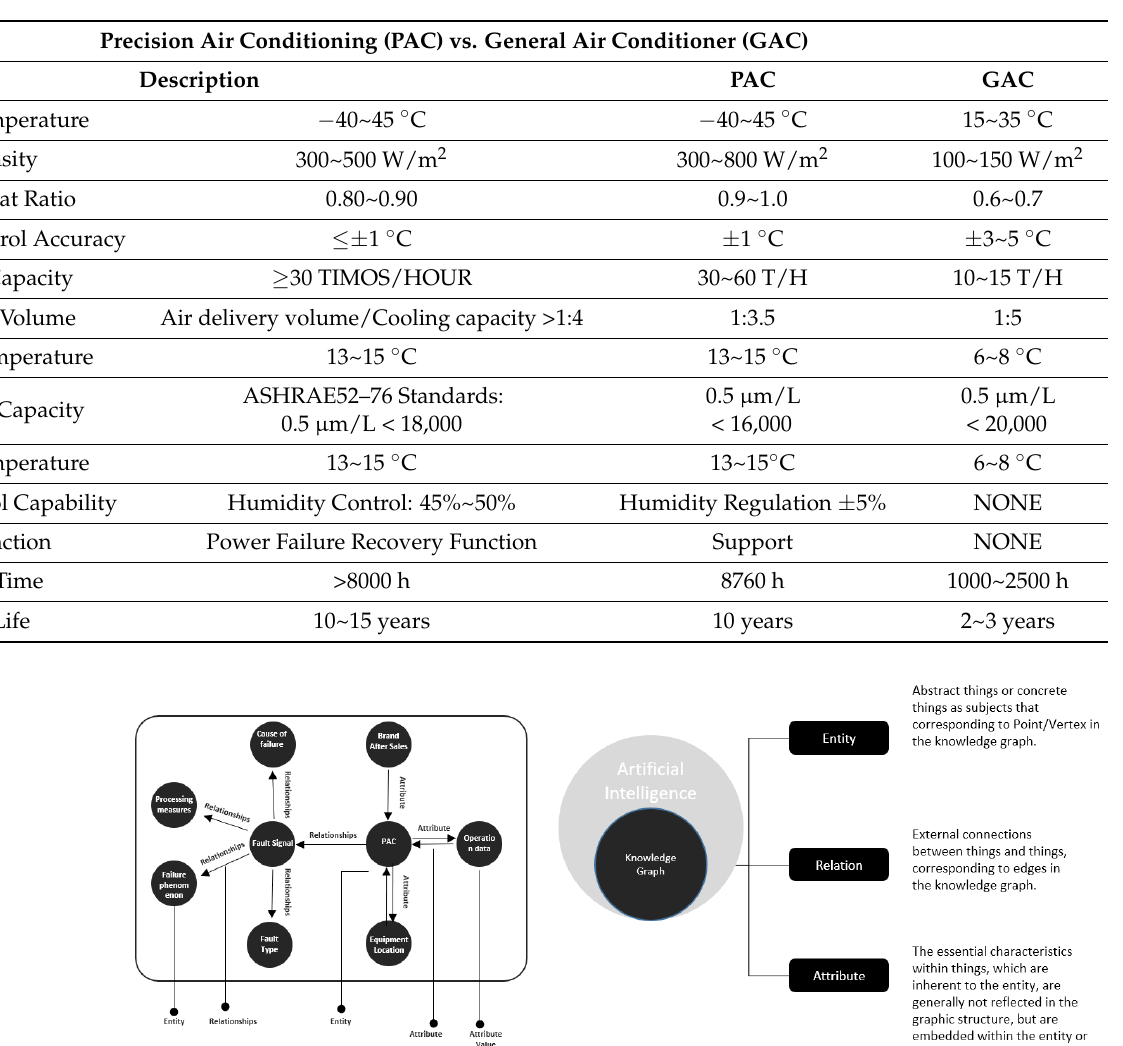
Table 1. Precision Air Conditioning (PAC) VS General Air Conditioner (GAC).